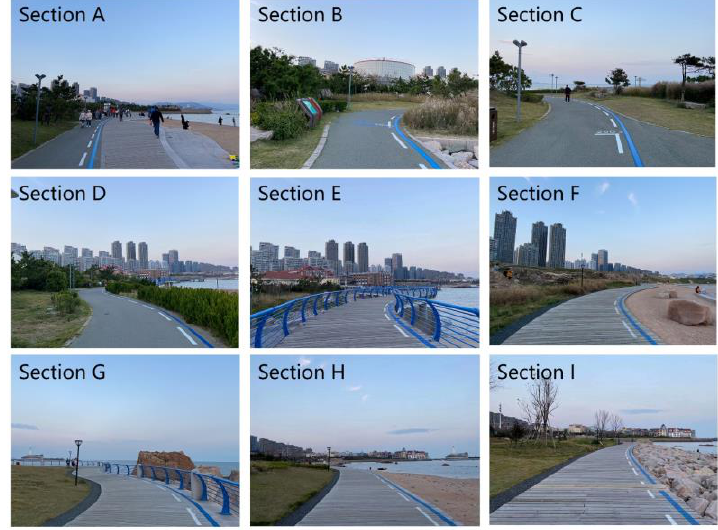
Figure 4. The photo of Section A to Section I. Table 1. Vegetation coverage, and paved area coverage of each section. Section